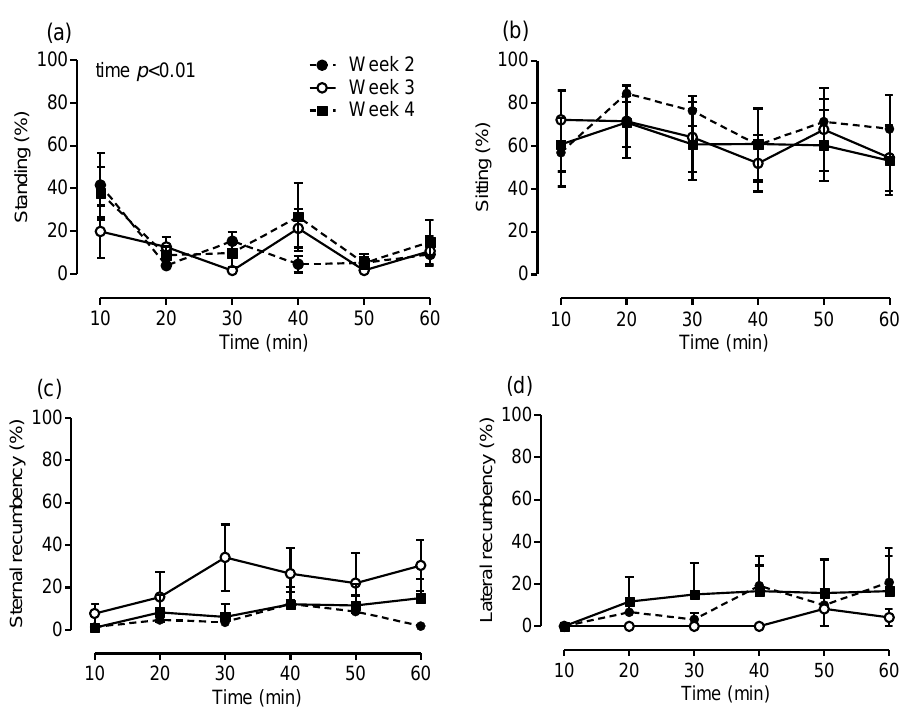
Figure 4. Time spent ( a ) standing, ( b ) sitting, ( c ) in sternal recumbency and ( d ) in lateral recumbency in dogs ( n = 6) transported three times for one hour at one week intervals (weeks 2–4). Times are given as percentage for each position for subsequent 10 min intervals. Values are means ± SEM, significant differences are indicated in the figures.